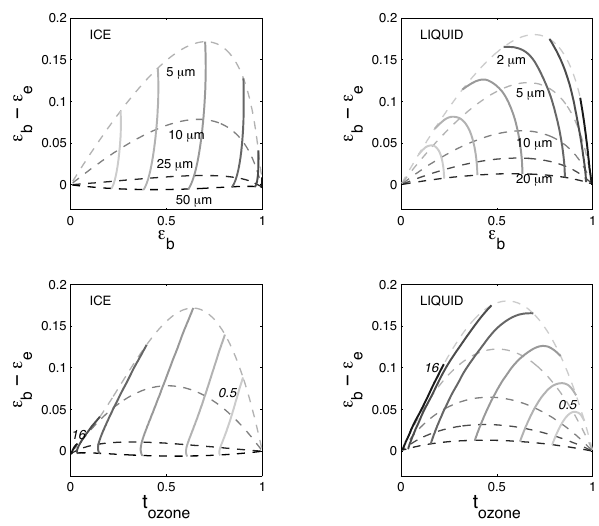
Fig. 4. “Arch plots” of split window cloud emissivity at 862.5cm − 1 ( ε b ) and 935.8cm − 1 ( ε e ), and cloud transmittance at 1040cm − 1 ( t ozone ) for liquid and ice clouds, for a spread in effective radii r e (dashed: as labelled) and optical depths τ (solid: 0.5, 1, 2, 4, 8, 16).